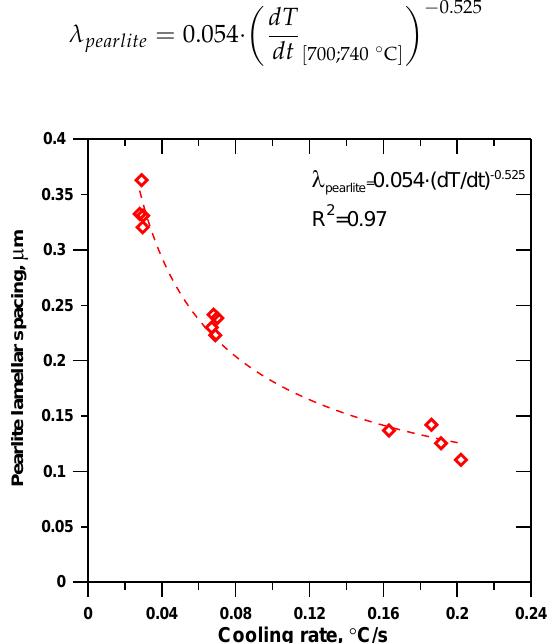
Figure 1. Pearlite lamellar spacing as function of cooling rate between 700 and 740 °C.